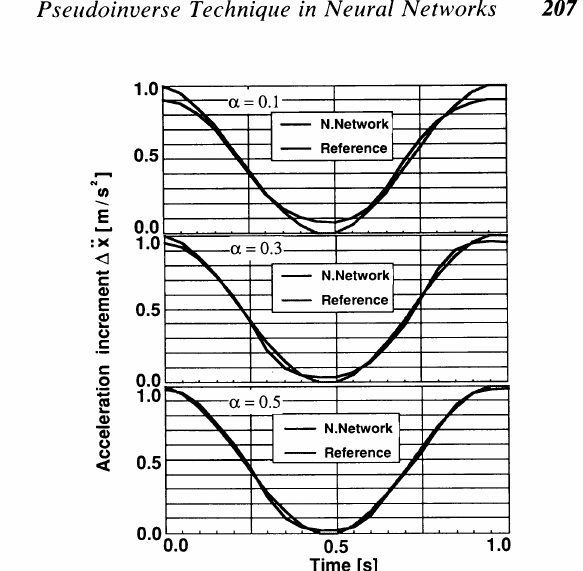
FIGURE 8 Results of dynamic system identification after 100 iterations by pseudoinverse method.